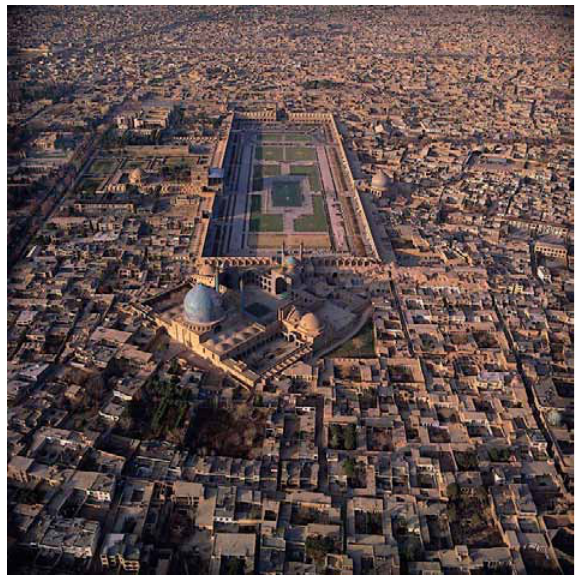
fig. 3. aerial photo of naghsh-e jahan Square Source: